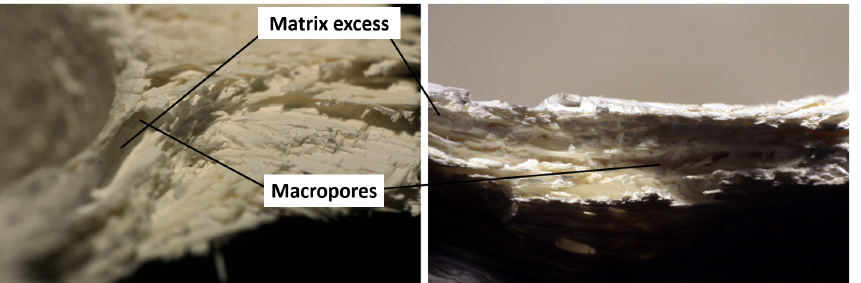
Figure 25. Defects resulting from manufacturing in the transition area between cylindrical combustion chamber and